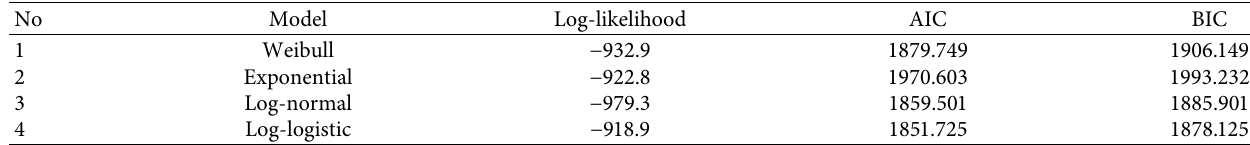
Table 4: Comparison of models for glaucoma patient’s